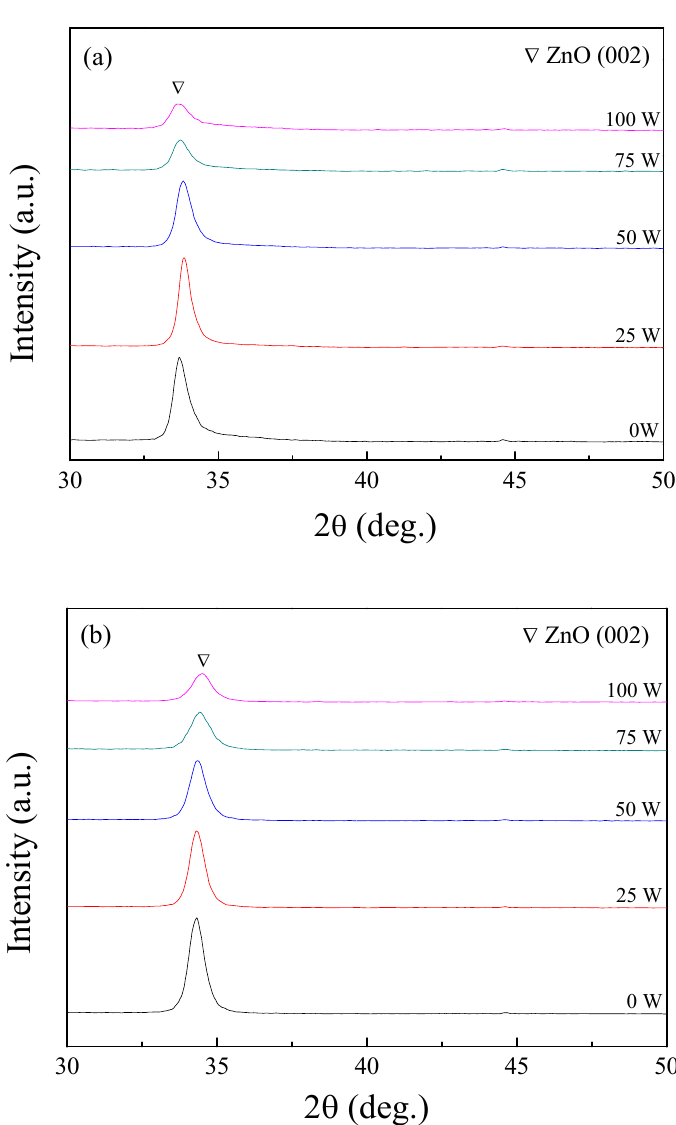
Figure 1. X-ray diffraction system (XRD) spectra of the Mg-doped AZO thin films ( a ) before and ( b ) annealed at 600 °C for 5 min.